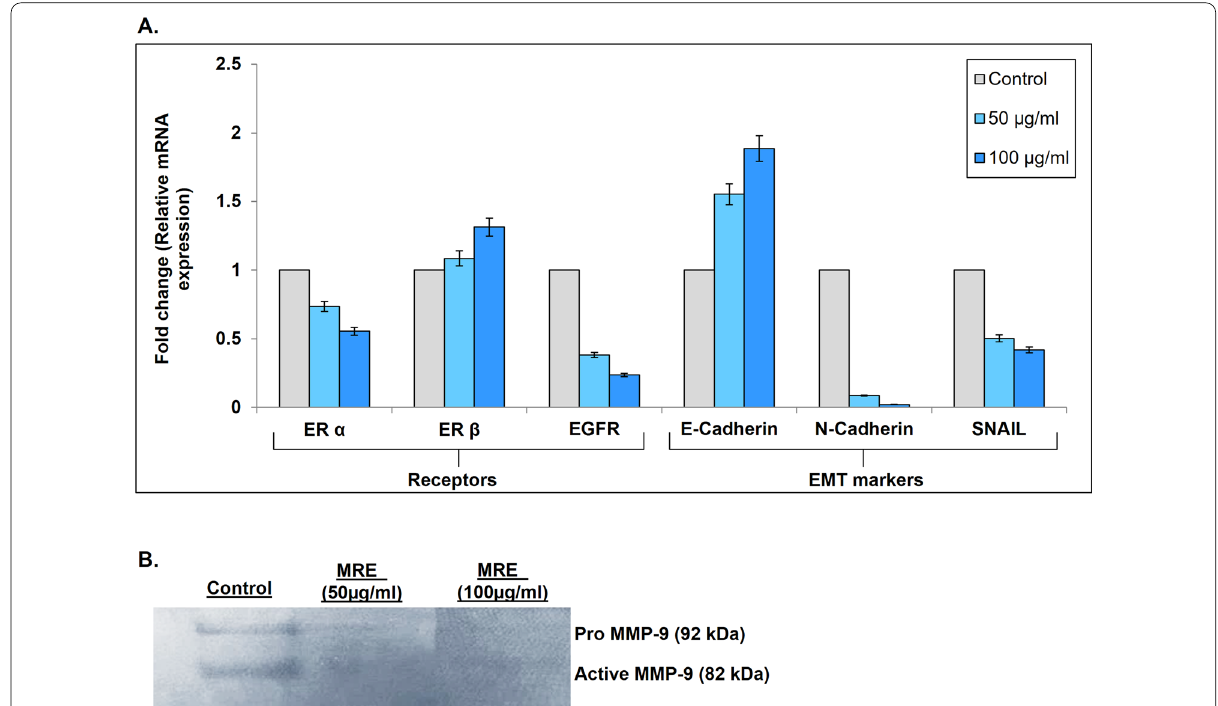
Fig. 3 Mangosteen rind extract (MRE)-induced expression of hormone receptors and EMT markers in MCF-7 cells. A Messenger RNA expression of ERα, ERβ, EGFR, and EMT markers in MCF-7 cells. MCF-7 cells were treated with MRE (0, 50, and 100 μg/ml) and the effect of MRE on gene expression were studied. Messenger-RNA expressions were analyzed using real-time PCR and the experiments were done in triplicates. ERα Estrogen receptor alpha, ERβ Estrogen receptor beta, EGFR Epidermal growth factor receptor, SNAIL Zinc finger protein SNAI1 (Snail), = = = = EMT Epithelial-mesenchymal Transition, MMP Matrix metalloproteases. B Effect of MRE on activity of MMP-9 in MCF-7 cells. MMP-9 activity was = = analyzed using Gelatin zymography. The dark bands against the light background (reversed from original image) showed the activities of pro and active MMP-9